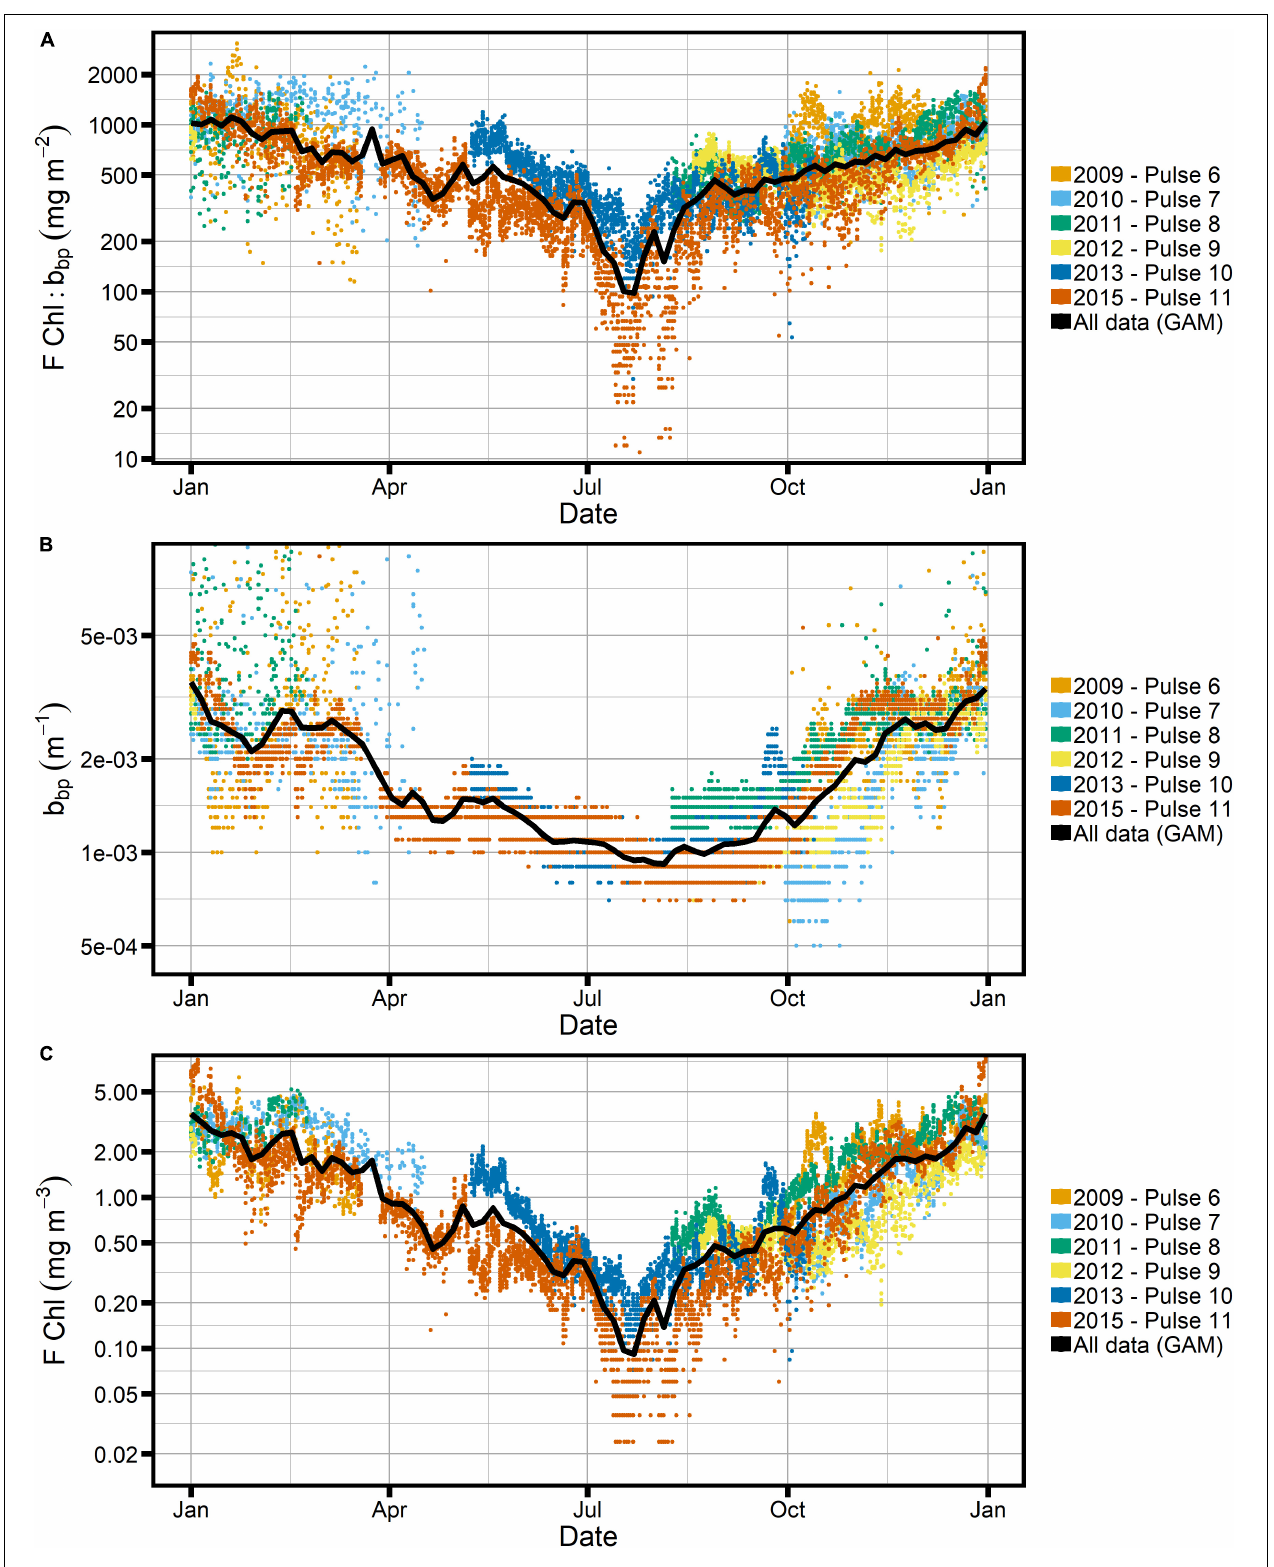
FIGURE 9 | Seasonal cycle of all Pulse mooring data at the SOTS site, using only factory calibrations and with GAM shown in black. (A) Ratio of chlorophyll fluorescence, FChl, to particulate backscatter, b bp . (B,C) The individual properties. Note logarithmic scale for the y -axis in all panels.